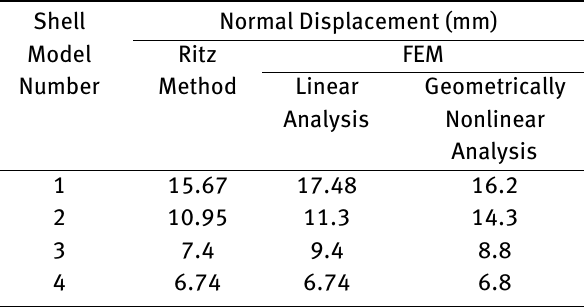
Table 3: Geometric characteristics of shell models Shell Model Number